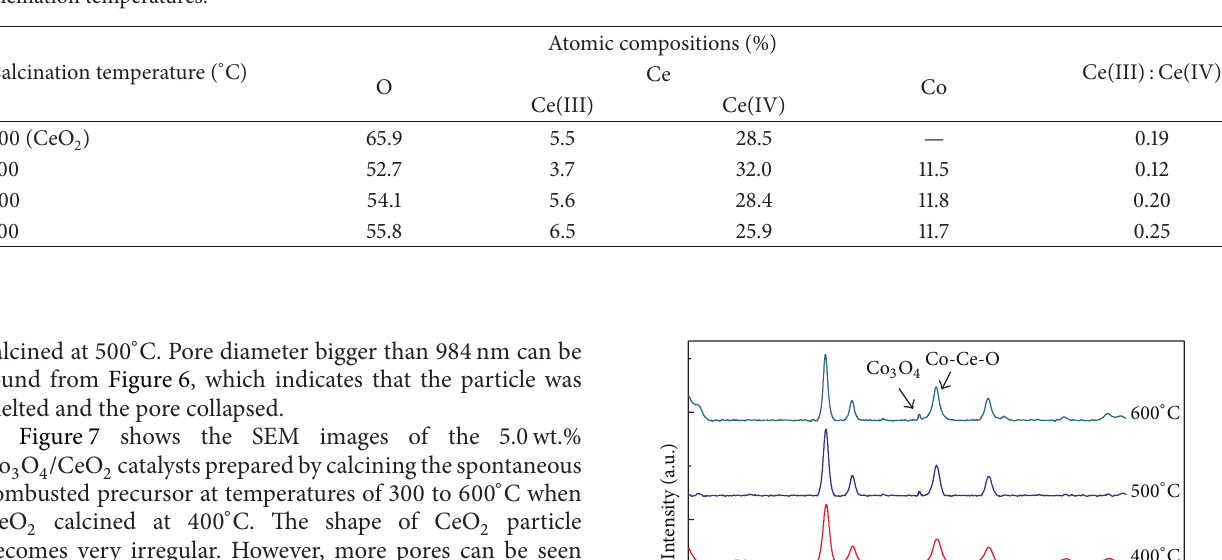
O doping at different calcination temperatures. 3 4